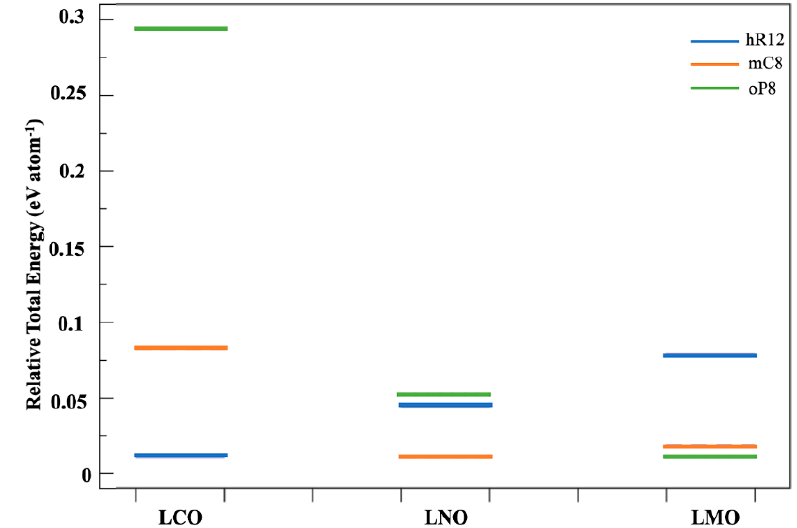
Figure 4. Relative phase stabilities for LCO, LNO and LMO compounds as computed by DFT + U.